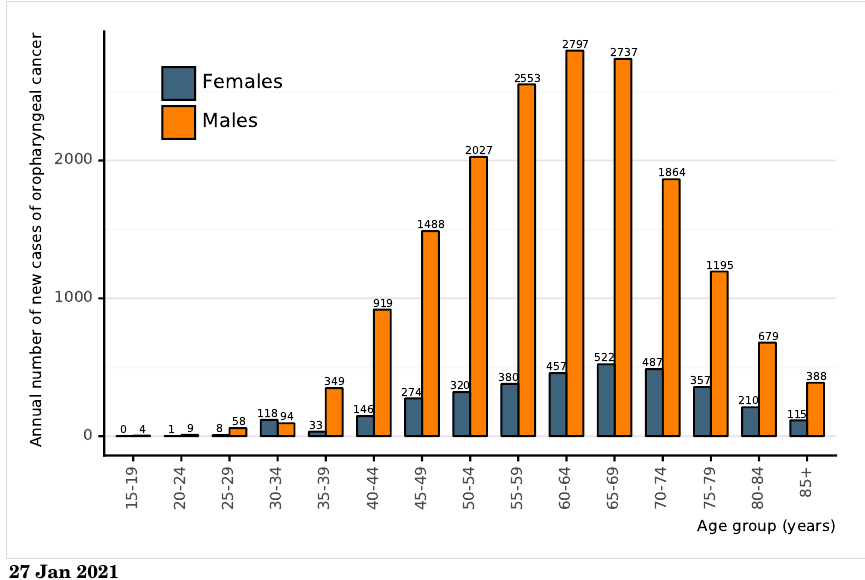
Figure 37: Annual number of new cases of oropharyngeal cancer in India (estimates for